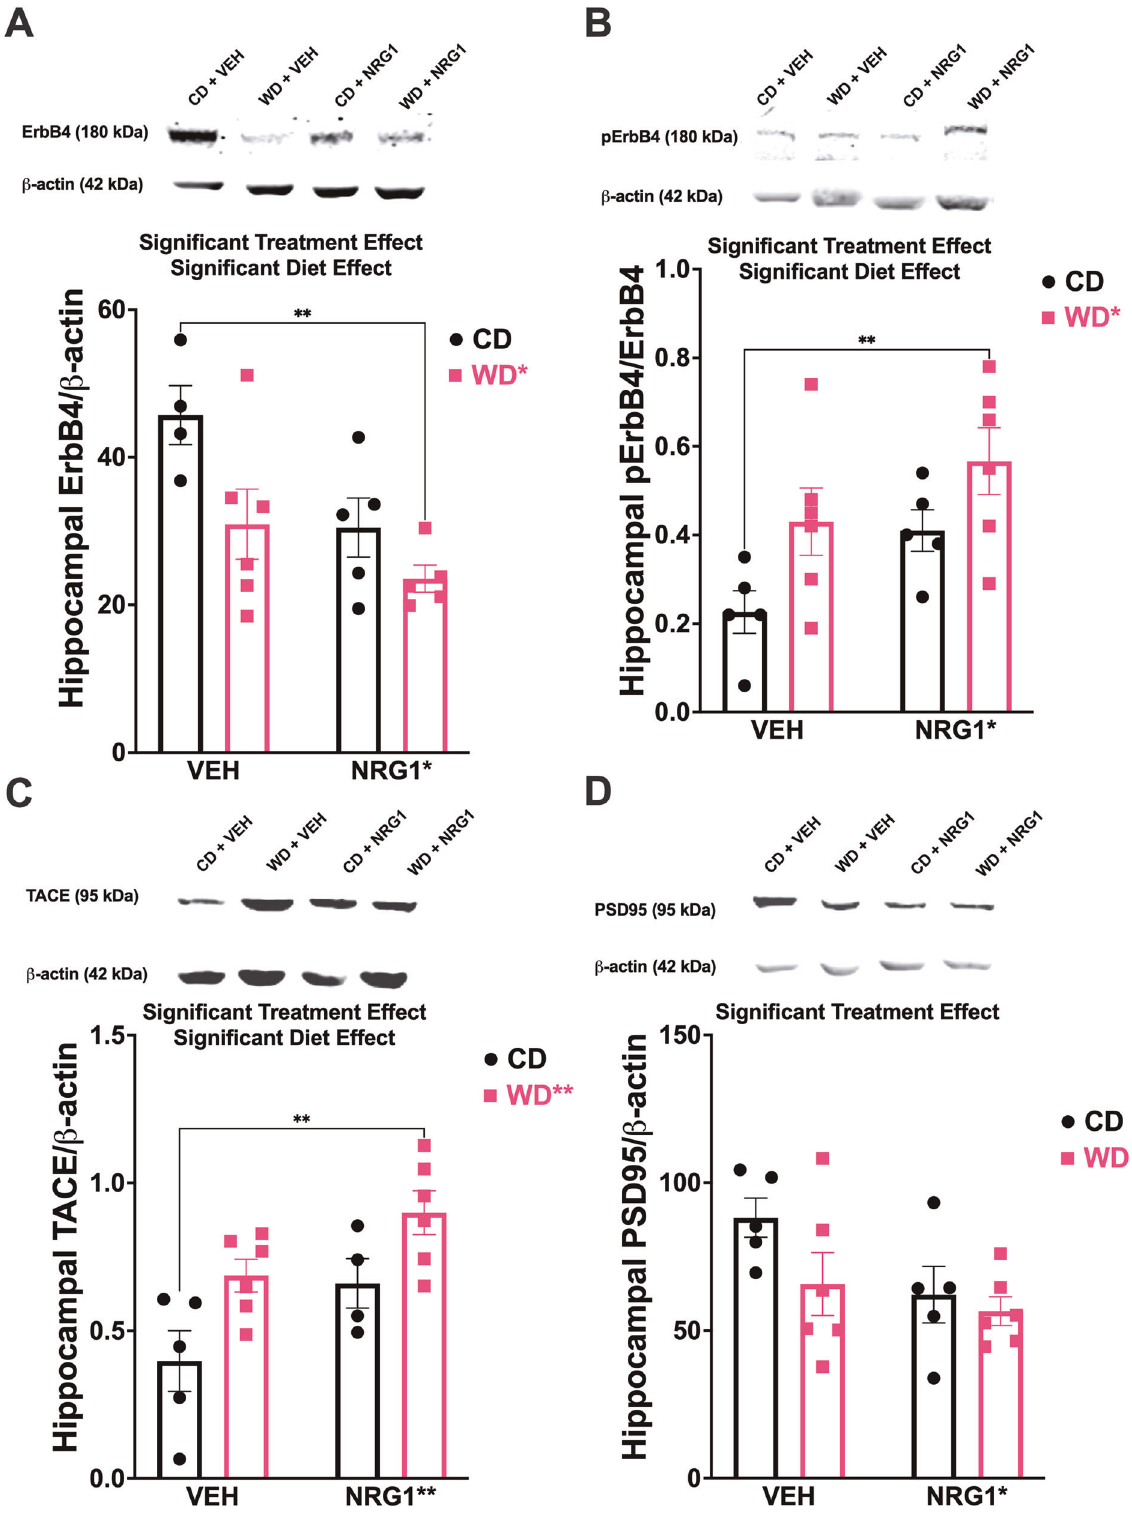
phosphorylation. TACE/ADAM17 activities may lead to reduced ErbB4 and also to ErbB4 transactivation [90]. We performed Pearson ’ s correlation analyses to test this idea. ADAM17 hippo- campal protein levels showed a robust signi fi cant correlation with ErbB4 protein levels ( r = − 0.59, p = 0.007; Fig. 7A).